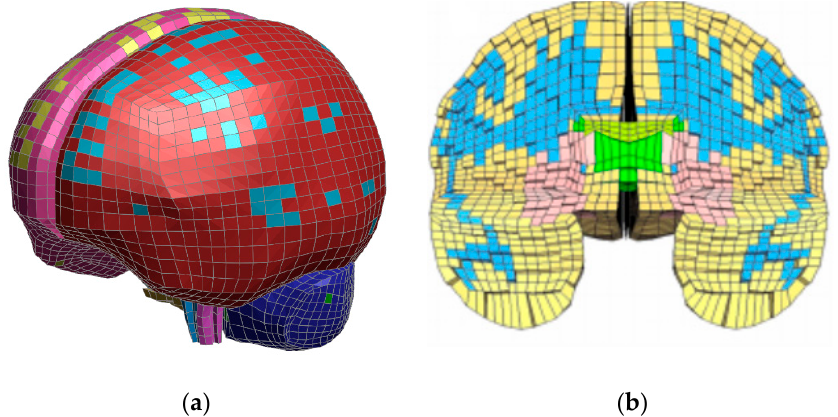
Figure 1. THUMS4.01 brain meshed model ( a ) [26] vs. GHBMC brain meshed model ( b ) [25]. ( a ) THUMS brain model, ( b ) GHBMC brain model (cross-section). ( a ) THUMS brain model, ( b ) GHBMC brain model